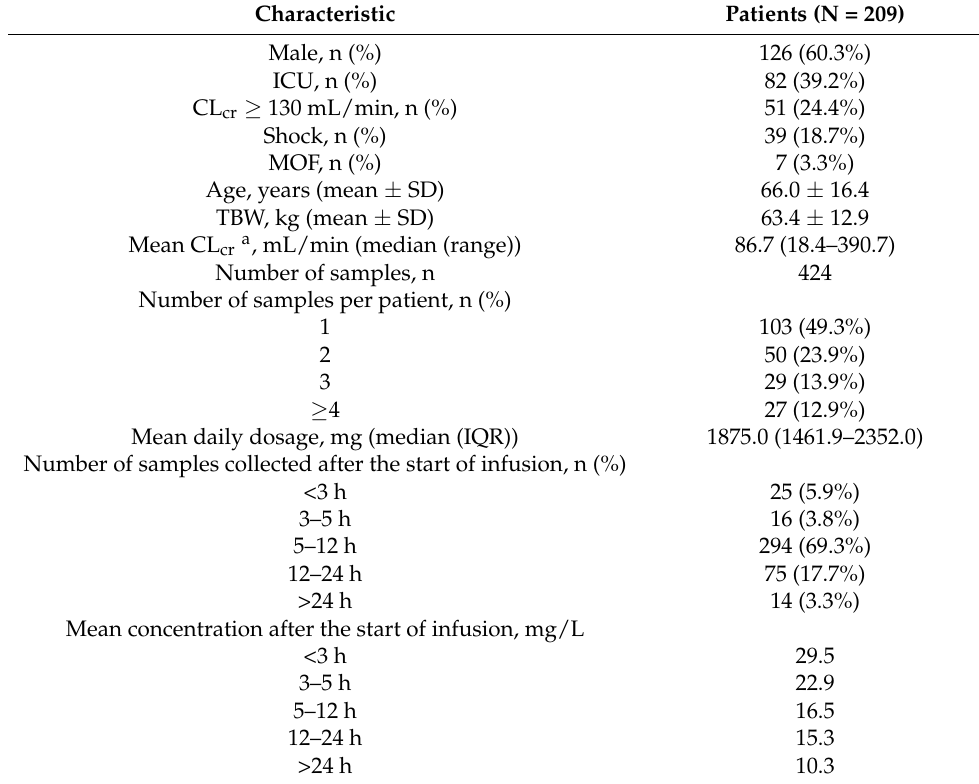
Table 1. Demographic characteristics of